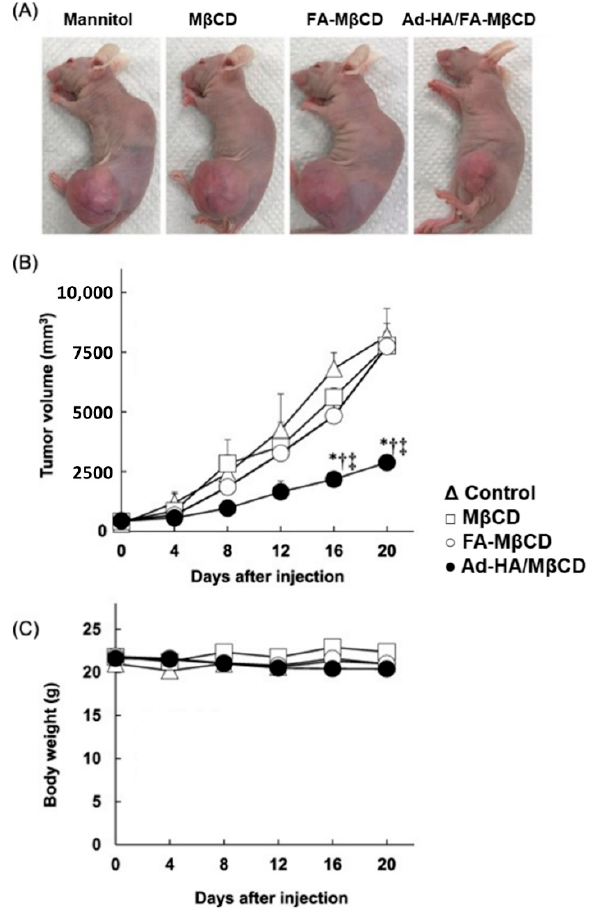
Figure 6. Effects of adamantane-grafted hyaluronic acid/folate-appended methyl- β -cyclodextrin (Ad-HA/FA-M β CD) on tumor growth ( A , B ) and body weight ( C ) after an intravenous administration to BALB/c nu/nu mice bearing HCT116 cells. * p < 0.05, compared with control (5% mannitol solution). † p < 0.05, compared with M β CyD. ‡ p < 0.05, compared with FA-M β CyD. Reprinted with permission from Ref. [156]. 2018, Elsevier B.V.